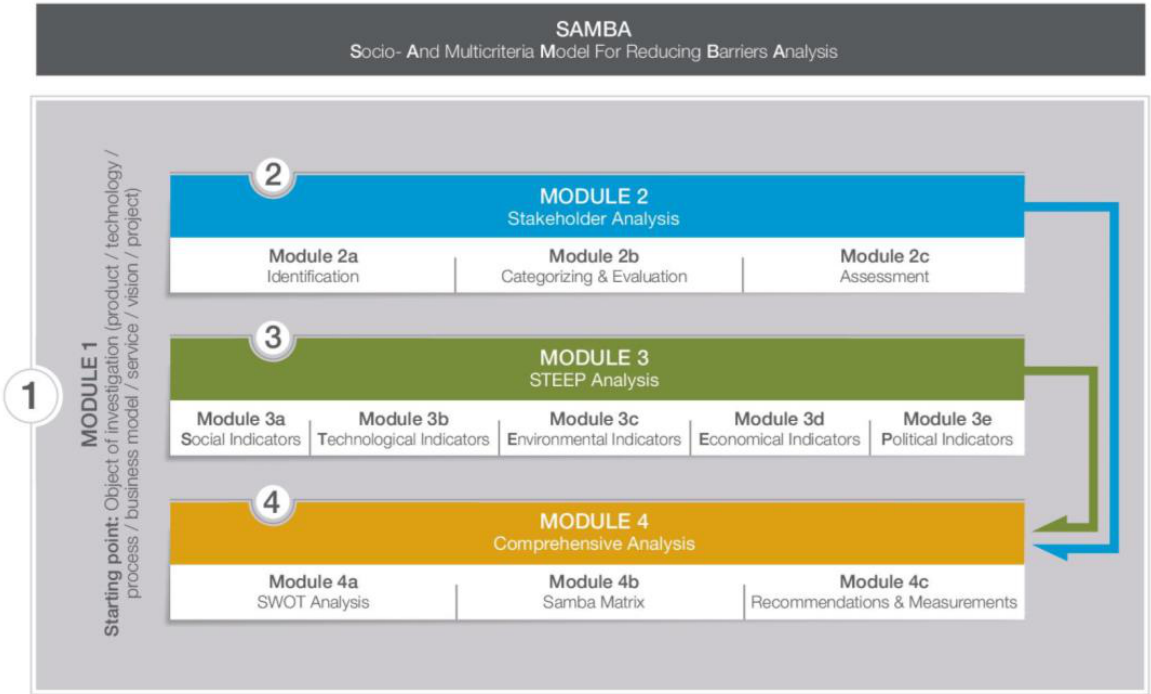
Figure 1. Socio-technical analysis with the model SAMBA.